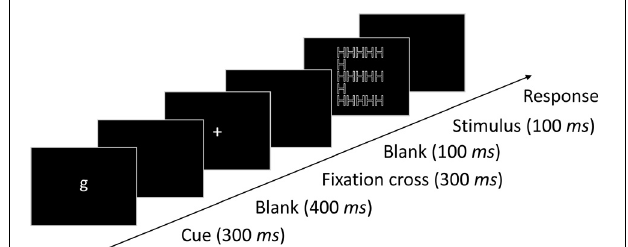
FIGURE 2 | The procedure applied in the experiment. In this example the cue (g) indicates global as target